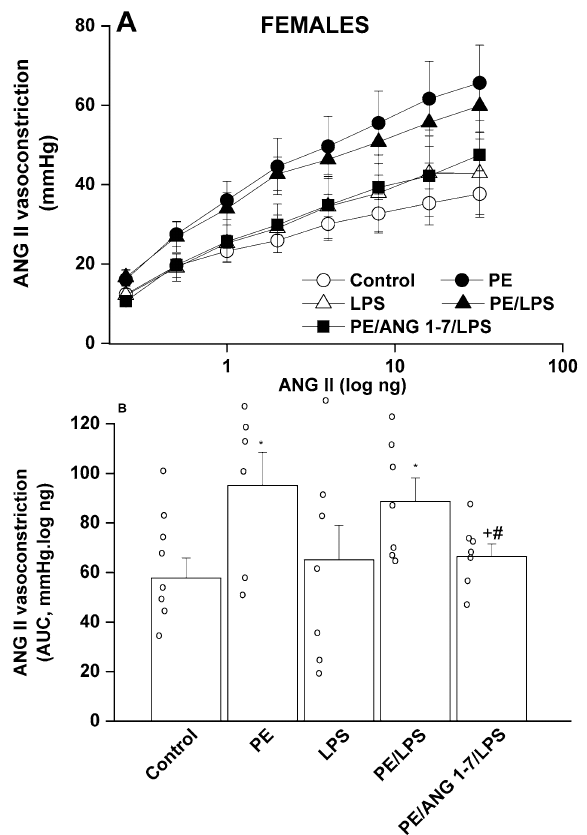
Figure 4. Effect of PE programming on cumulative vasoconstrictor response curves of Ang II ( A ) and AUCs of the Ang II cumulative vasoconstrictor response curves ( B ) measured 4 h post LPS challenge (5 mg/kg) in isolated perfused kidneys of adult female offspring. The influence of prenatal administration of Ang1-7 is also shown. Contractile responses were estimated as changes from basal renal perfusion pressure. Values